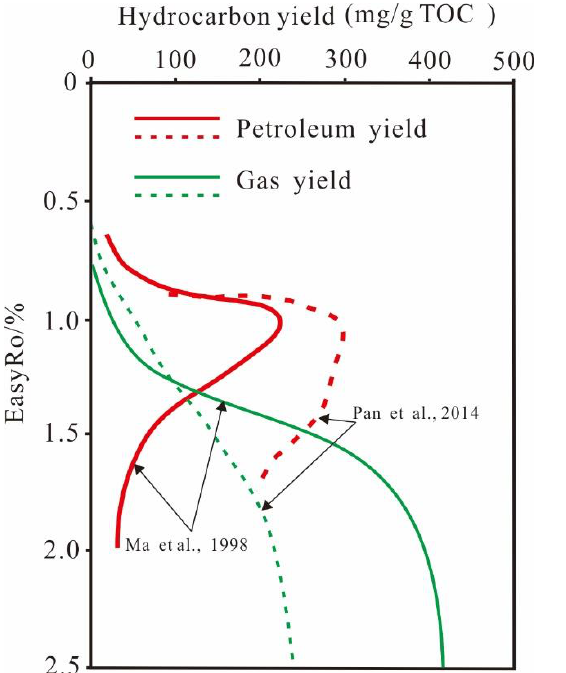
Figure 9. Comparison of hydrocarbon generation models of source rocks in the Permian Fengcheng Formation